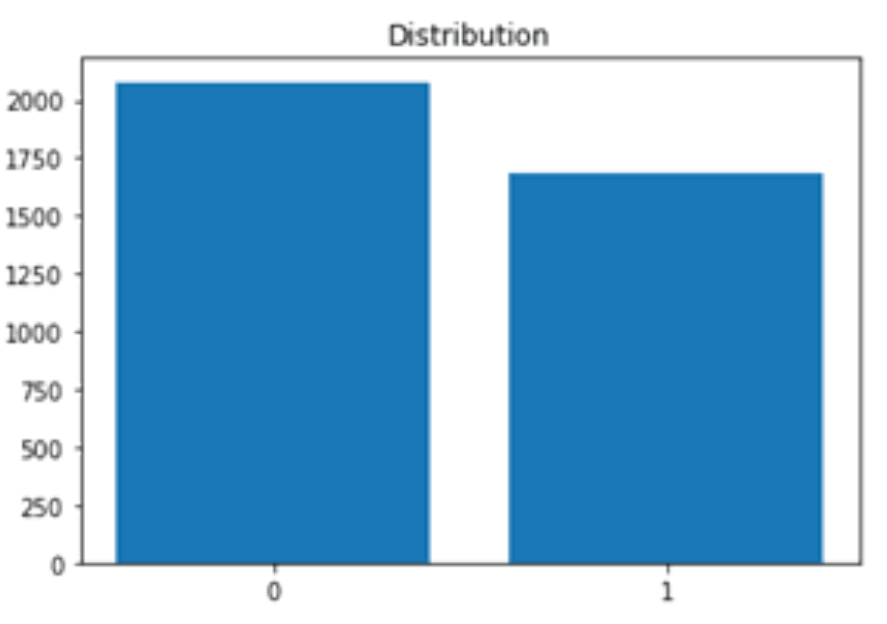
Figure 15. Data classification.